Question: Express in one sentence what the figure is showing.
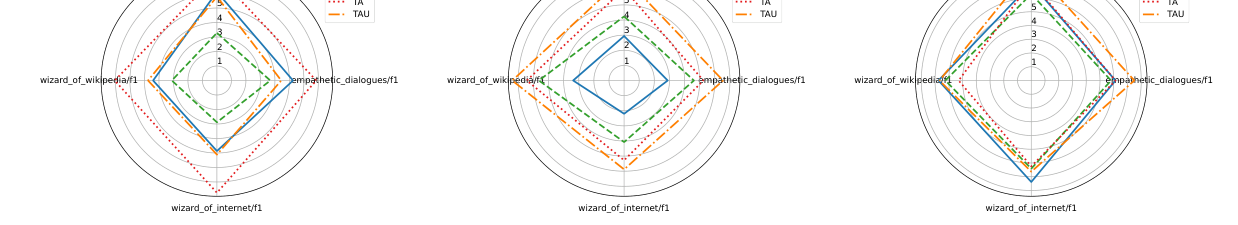
Answer: Average F1 scores for dialogue tasks. Unlearning 8 (left), 32 (middle), and 128 (right) samples. On the 125M model. The key discovery here is that TA and/or TAU perform best in small LLMs.